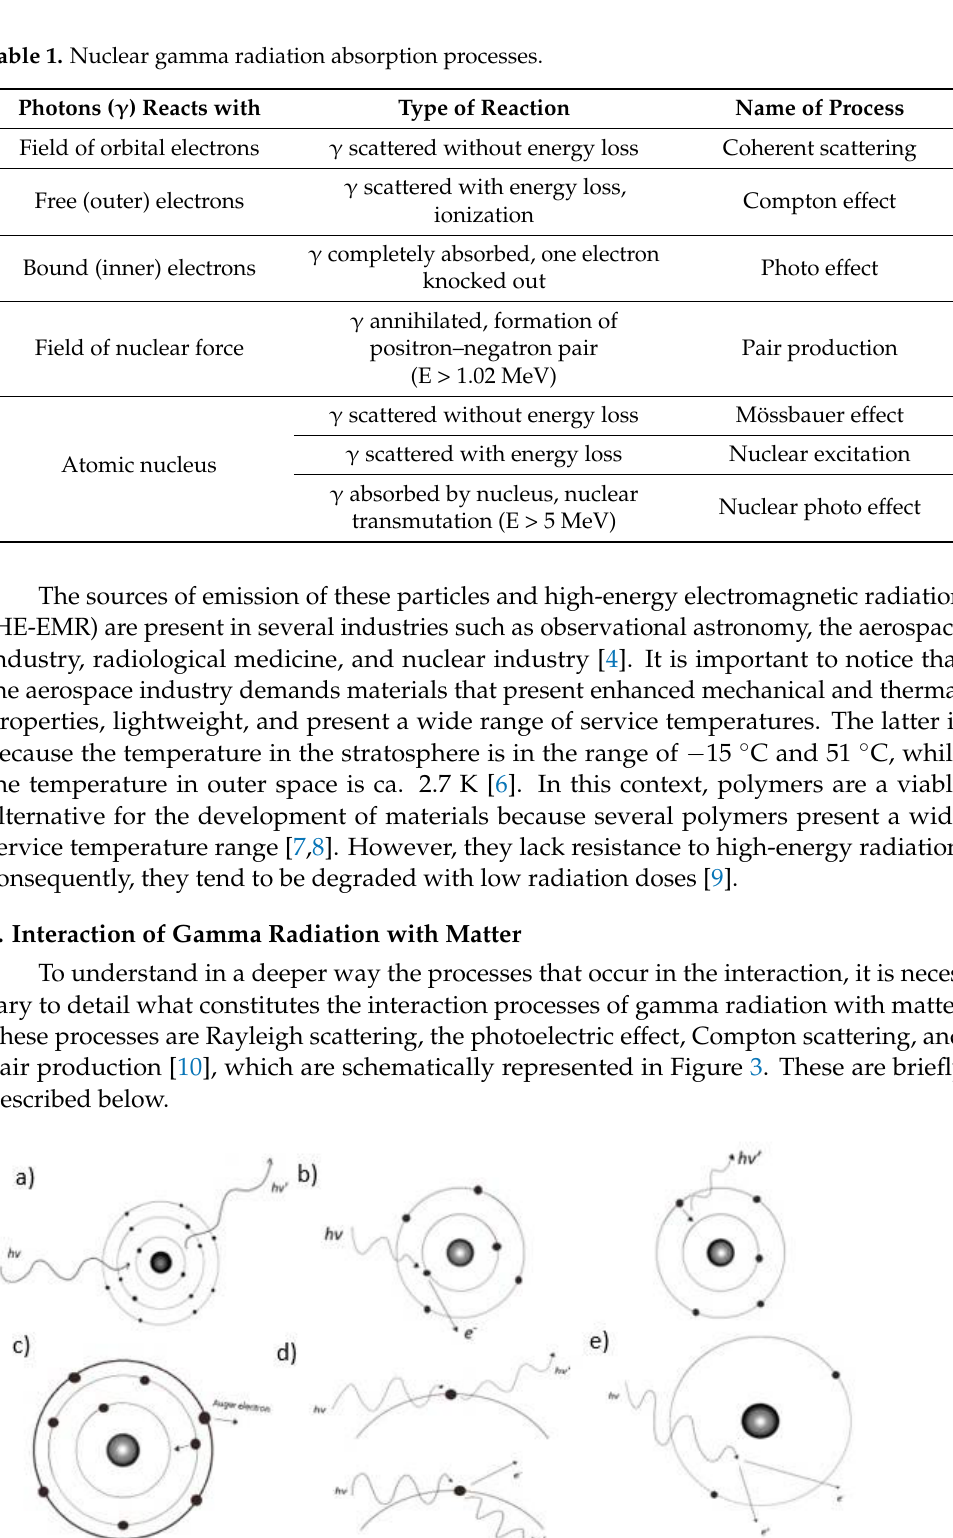
Table 1. Nuclear gamma radiation absorption processes.